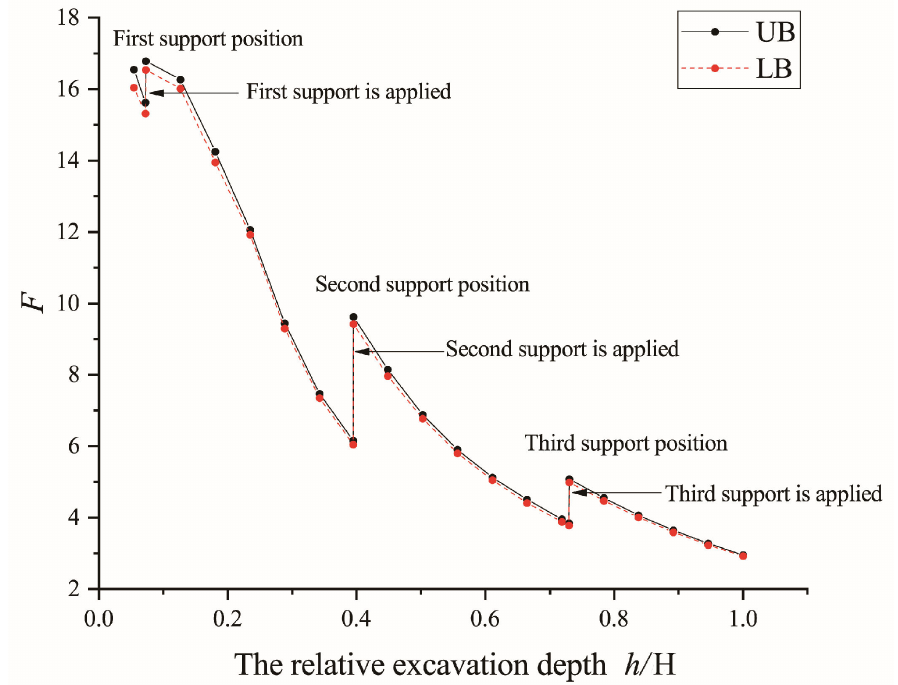
Figure 26. Influence of the relative excavation depth h /H on the safety factors F of the foundation